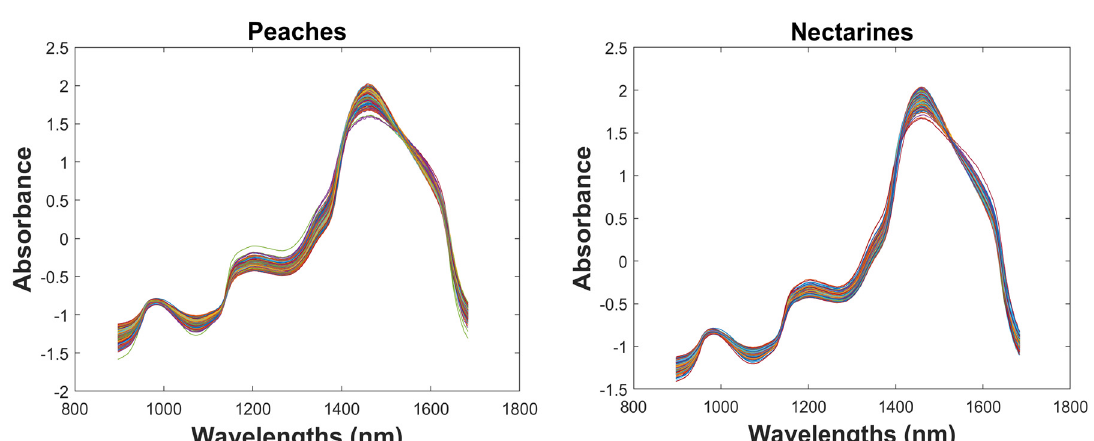
Figure 5. Near-infrared (NIR) absorbance spectra for the fruits of the 2019 season without any preprocessing (first line) and with the standard normal variate (SNV) procedure (second line), for ( a ) peaches and ( b ) nectarines.